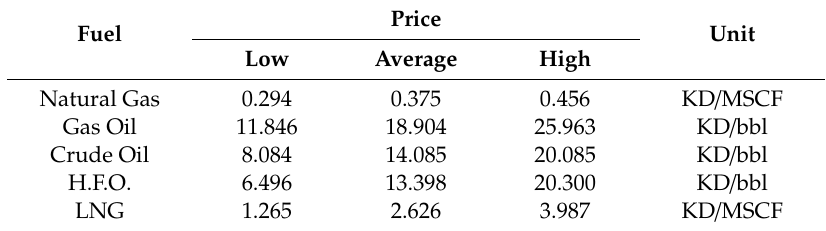
Table 7. Average prices of the di ff erent fossil fuels used in power generation in Kuwait. Fuel